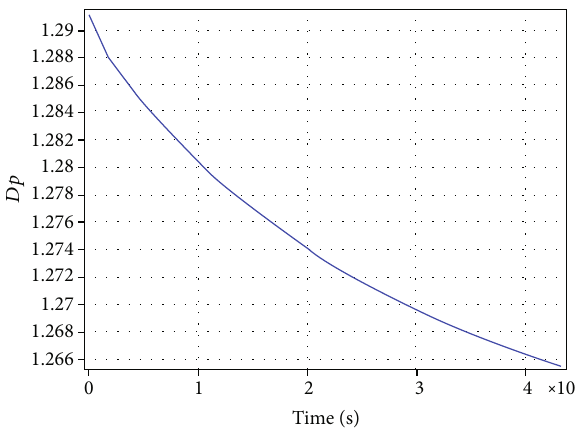
Figure 11: Evolution of the fractal dimension of throat diameter at the location (0.025, 0.05) by the fractal model.